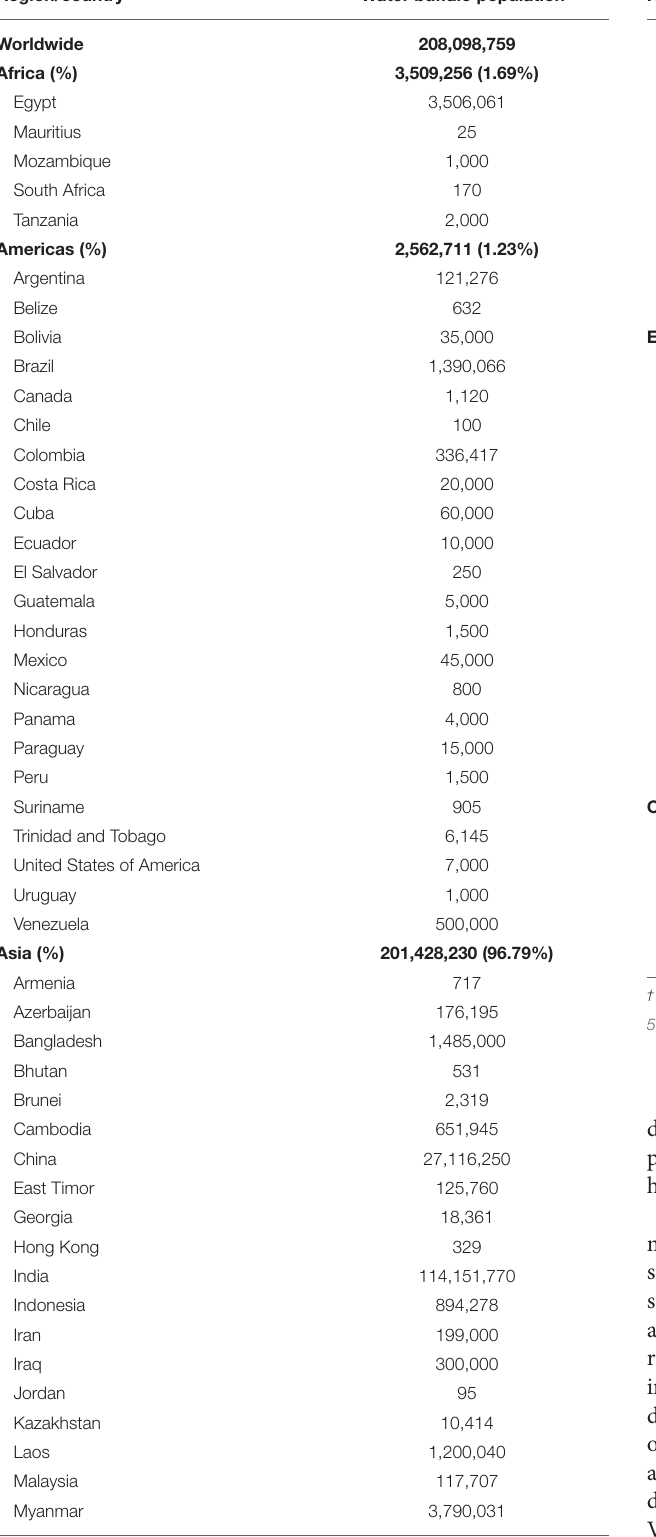
TABLE 2 | Current data on buffalo population worldwide. Region/country